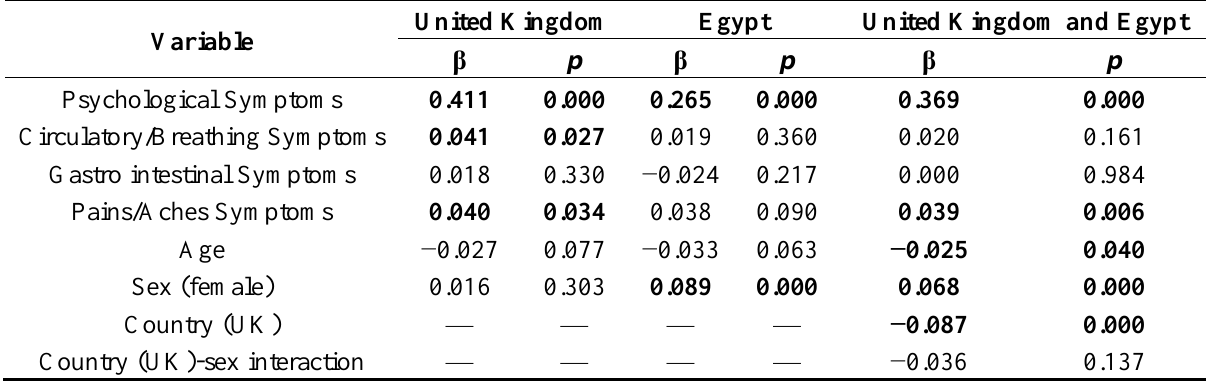
Table 7. Coefficients of Predictors of perceived stress among university students in the UK, Egypt and both countries together.